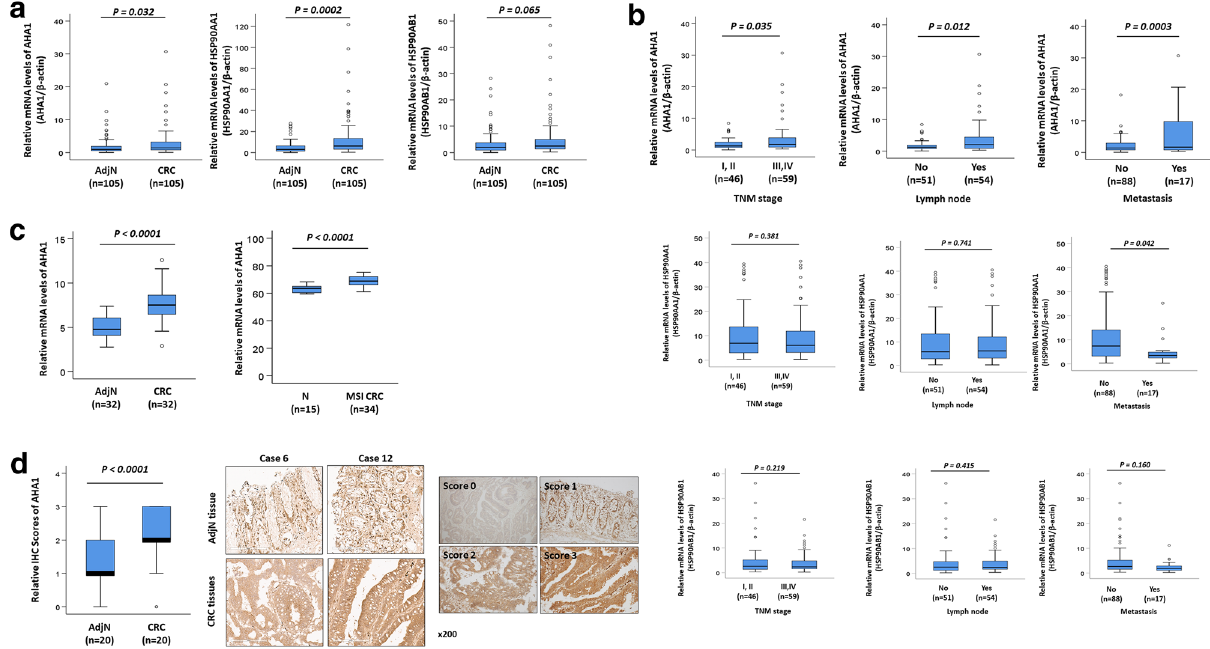
Figure 1. AHA1 is up-regulated in progressive and metastatic CRC patients. ( a ) The mRNA expression of AHA1 and HSP90AA1, but not of HSP90AB1, was significantly higher in CRC tissues compared to that in paired adjacent normal tissues. ( b ) The higher mRNA expression of AHA1 , but not HSP90AA1 and HSP90AB1, was associated with the progressive clinical characteristics, such as the TNM stage, LN involvement, and metastasis, in CRC patients. ( c ) The mRNA expression of AHA1 was significantly higher in 32 CRC tissues compared to that in 32 paired normal colonic mucosa tissues in GSE8671 datasets, as well as in 32 MSI CRC tissues, compared to that in normal colonic mucosa tissues in GSE24514 datasets. ( d ) AHA1 expression was higher in CRC tissues, compared to that in adjacent normal tissues, which was scored by the scoring system after IHC stating and quantified by assessing staining intensity using Leica’s Aperio ImagScope program (V12.4.0.5043, IL, USA). Representative IHC-stained photomicrograph images with AHA1 shown in CRC tissues, compared to adjacent normal tissues. AdjN adjacent normal specimen, CRC colorectal cancer specimen. Original magnification is